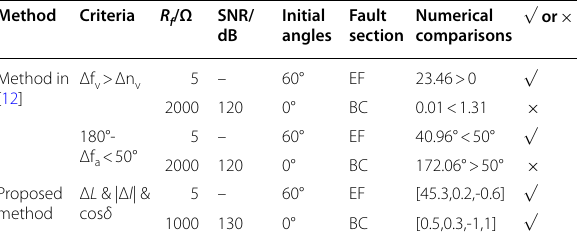
Δf v is the amplitude difference and Δf a is the direction difference, Δn v is the amplitude difference of the magnetic fields on both ends of the normal section